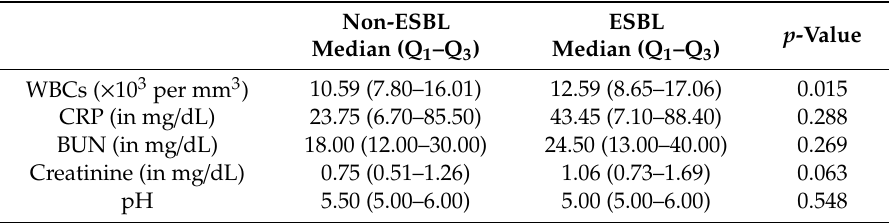
Table 5. Laboratory data related to non-ESBL vs. ESBL uropathogens. Mann–Whitney test were used to assess di ff erences between ESBL and non-ESBL groups for laboratory data. The level of statistical significance was set at p < 0.05.